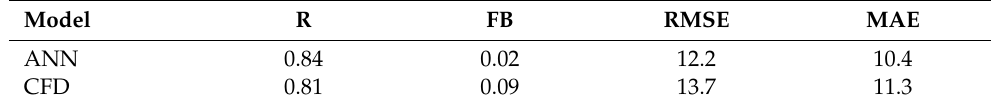
Table 3. Summary of model